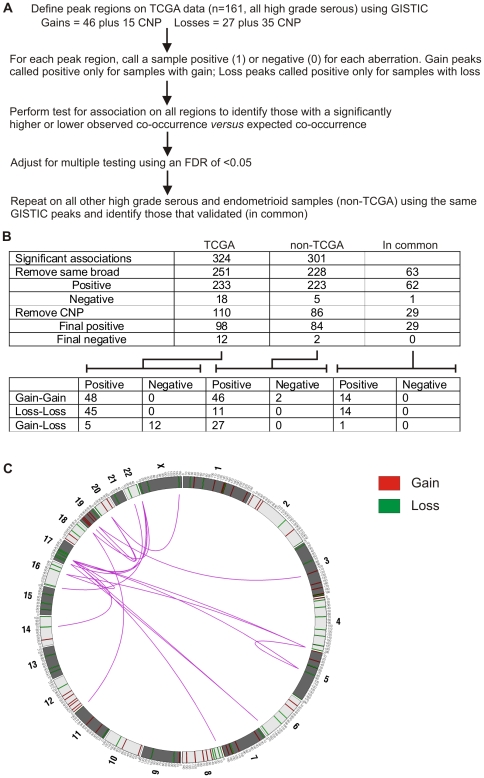
Analysis of association between copy number aberrations.(A) Process for identifying associated aberrations (more detail in Methods S1). (B) Summary of significant associations in each data set and those significant in both. As the table progresses, certain associations are filtered out, with the numbers remaining those that pass the filter. Firstly, associated loci that are within the same broad GISTIC intra-chromosomal region are removed and secondly regions that overlap with a CNP are removed. (C) Circos plot. Outer ring indicates the chromosome position of each aberration (coloured bars). The internal purple lines show the significant inter-chromosomal associations (exclusive of those involving a CNP) that have been validated in the second data set.